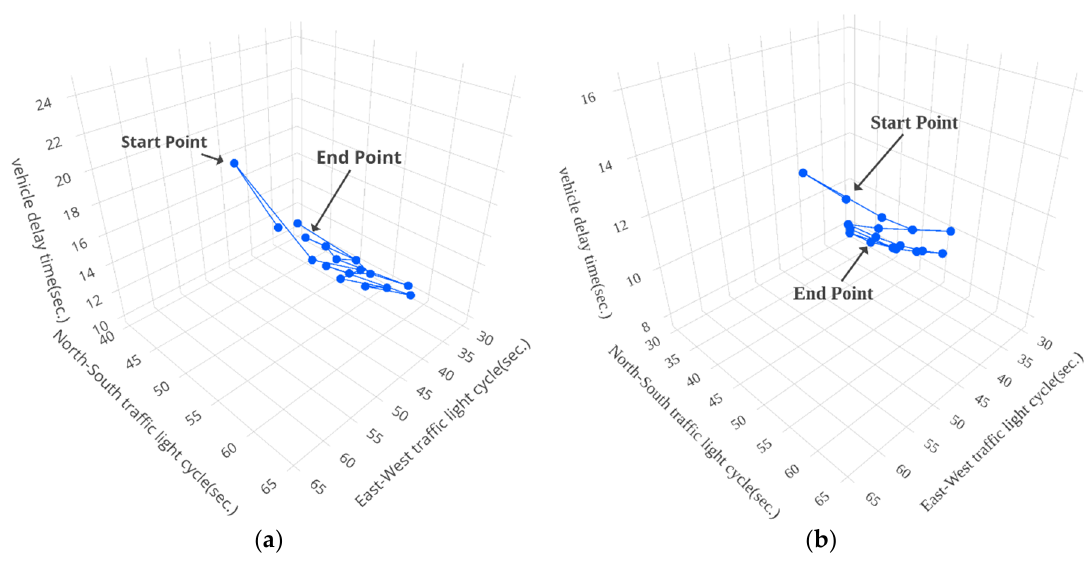
Figure 15. The results of vehicle delay by using our proposed modified Q-learning mechanism on Yanping N. Rd. and Minsheng W. Rd. ( a ) from 8:00 a.m. to 9:00 a.m. ( b ) from 5:00 p.m. to 6:00 p.m.